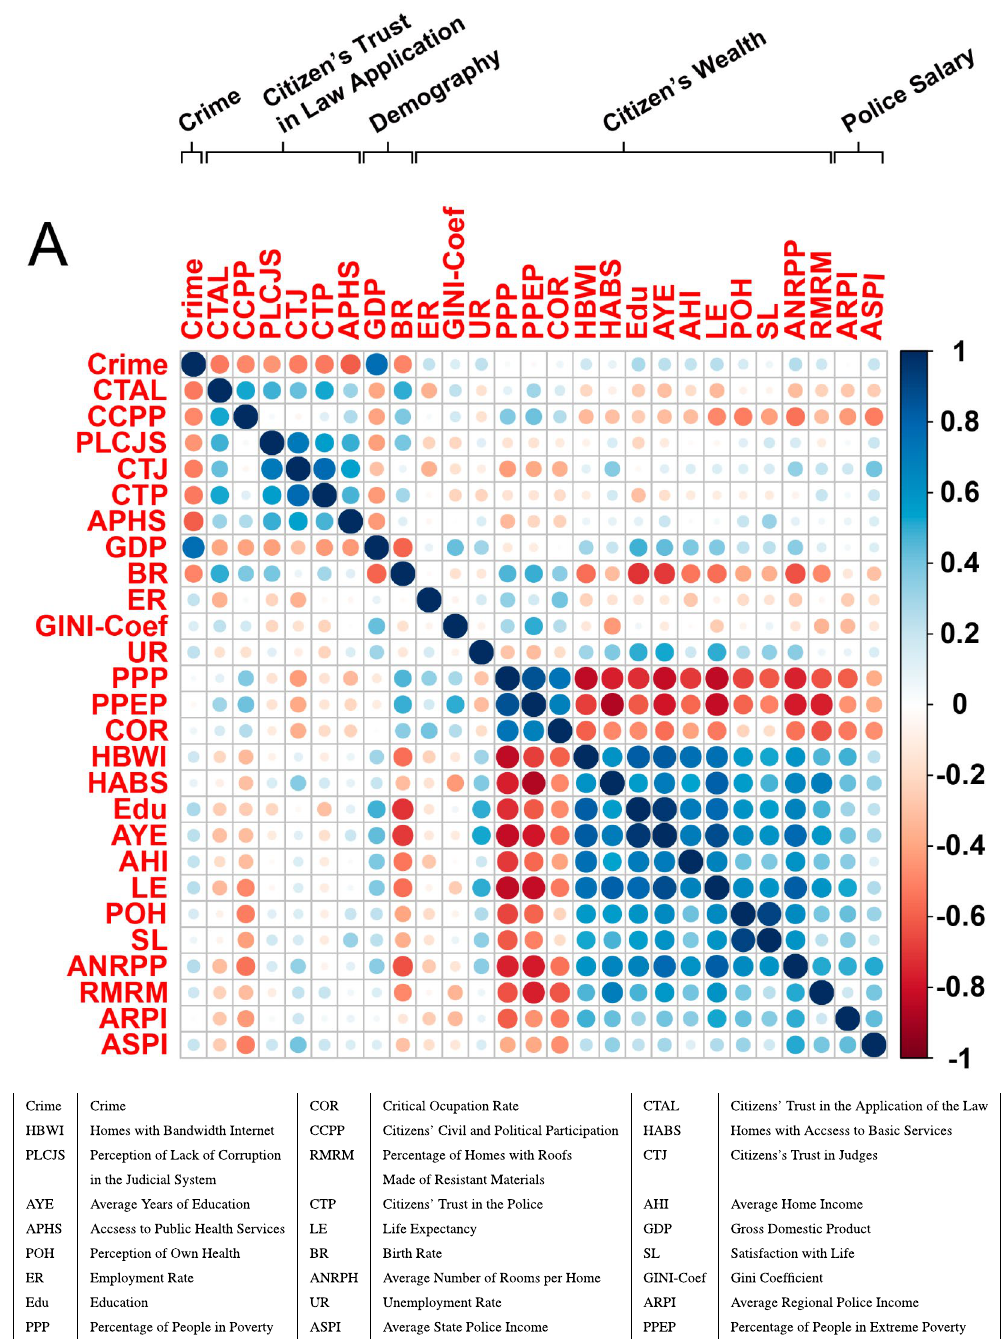
Figure 2. Correlation matrix between crime, trust in justice, and social welfare indicators. ( A ) The element in the first row and column (upper left corner) corresponds to the crime level (Crime). Note that crime is not significatively correlated with any of the social welfare indicators such as police salary, poverty, education, use of Internet, or family income. However, crime is highly anti-correlated (red dots, first row) with the parameters that measure citizens’ confidence in the police and justice system. Crime is also anti-correlated with access to public health services and birth rate. Interestingly, crime is positively correlated with Gross Domestic Product, a standard measure of wealth. ( B ) Meaning of the acronyms and abbreviations used in ( A ). The raw data to create this correlation matrix were taken from Semáforo Delictivo (crime) 26 and the National Institute of Geography and Statistics (justice and welfare indicators) 37